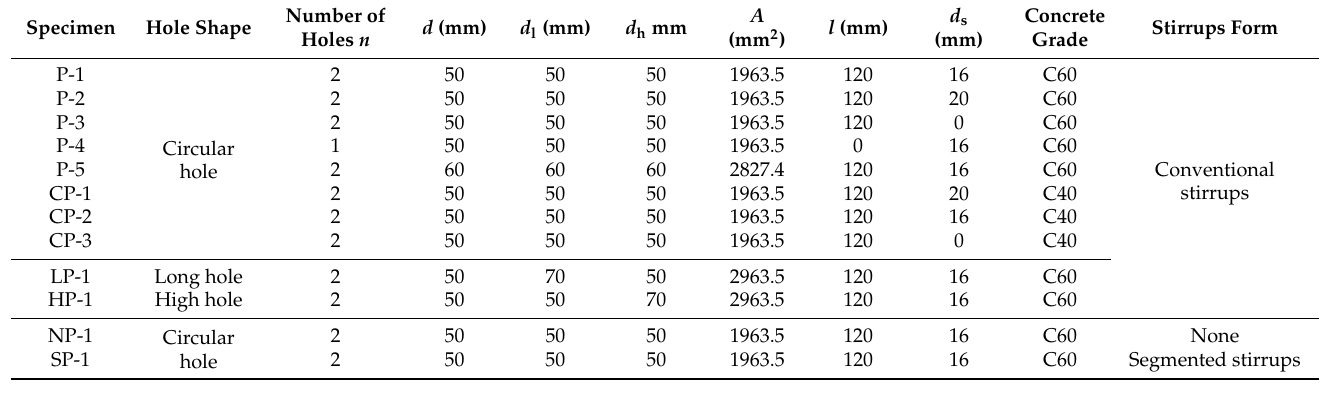
Table 1. Parameters of push-out specimens.